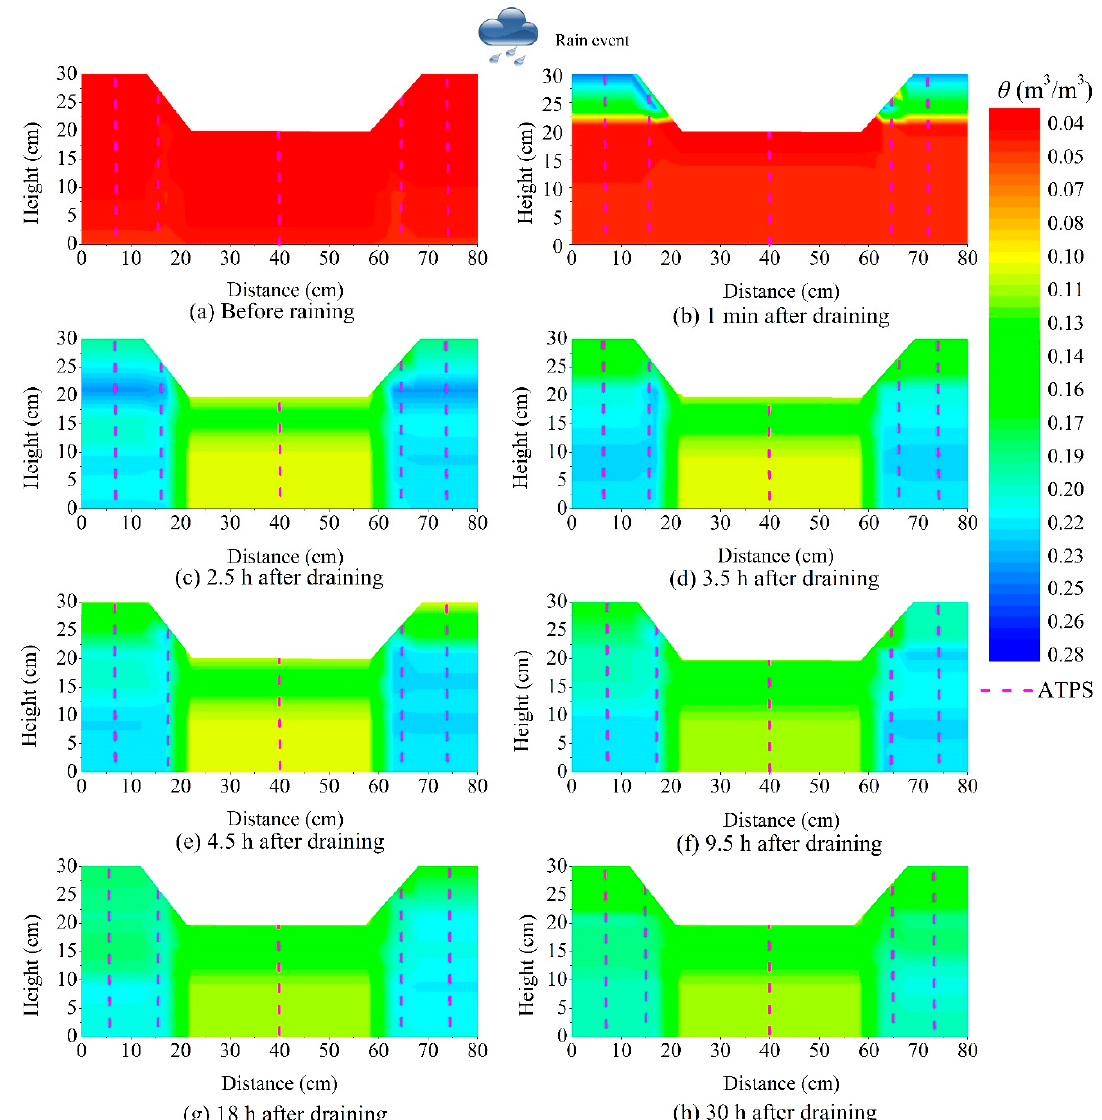
Figure 9. Soil moisture content (color) changes of the subgrade and slope after rainfall during the CM test.